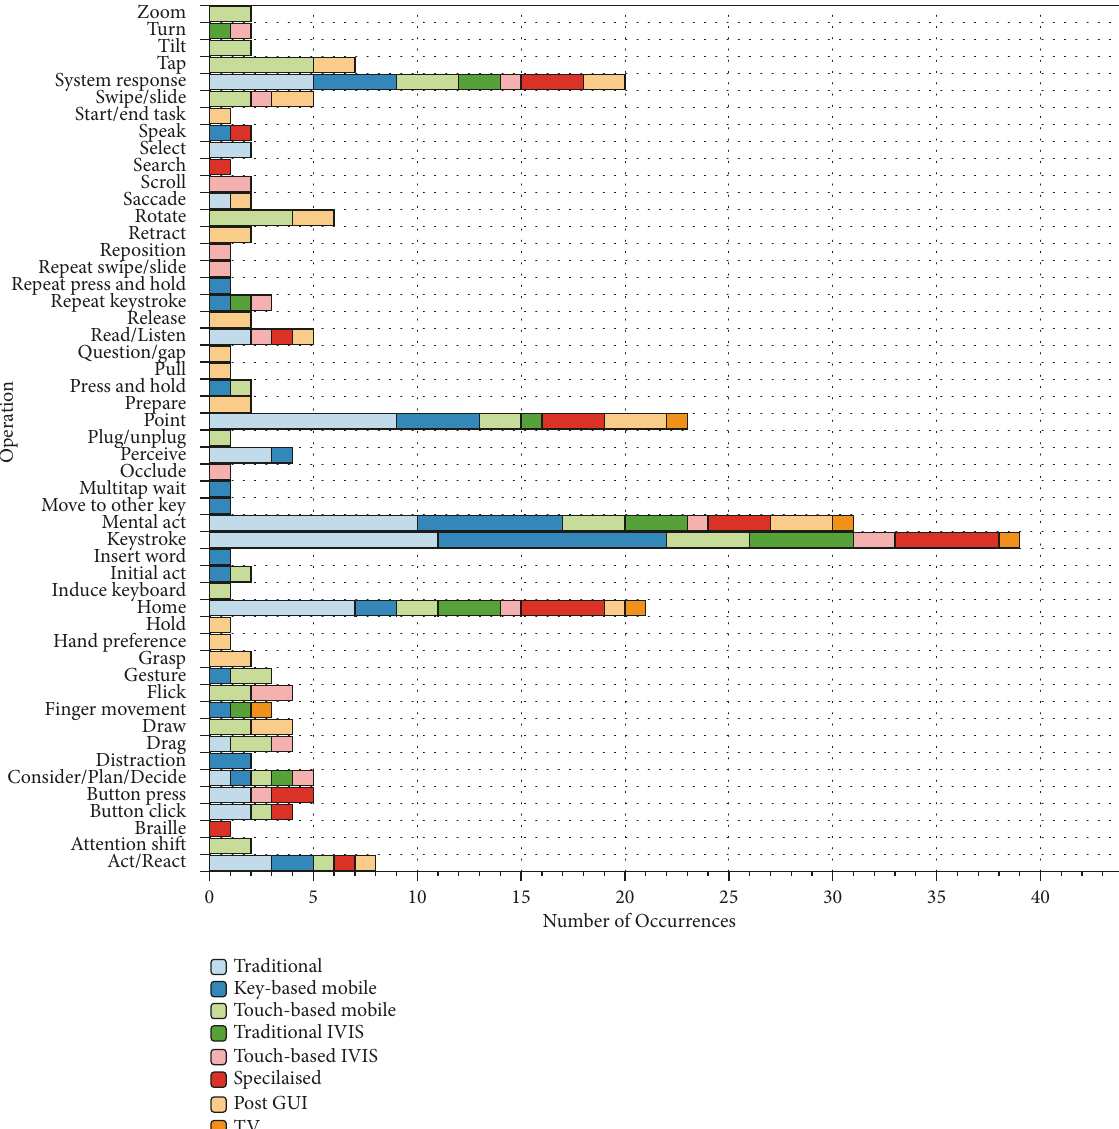
Figure 7: A bar chart of the collated operators and the frequency of adoption by the primary studies reviewed. The groups reflect the device setups previously discussed in Section 5.2.2: traditional, key-based mobile, touch-based mobile or tablet, traditional IVIS, touch-based IVIS, specialised, post-GUI, and